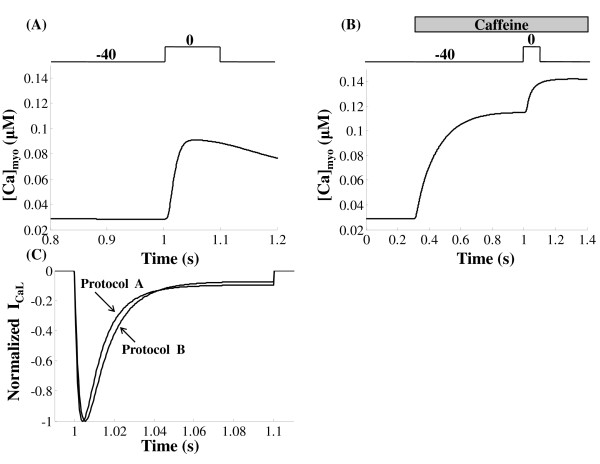
Effects of the application of caffeine. Figure 17: Model-simulated effects of the application of caffeine on ICa,L,TT and [Ca2+]i in a cell dialyzed with 2 mM Fura-2. Changes in [Ca2+]myo resulting from: (A) application of a simple depolarizing pulse from -40 mV to 0 mV, and (B) the same depolarizing pulse following pre-exposure to caffeine (5 mM). Panel (C) compares the ICa,L waveforms associated with these protocols. This model-generated result shows similarity to data in Figure 3, Adachi-Akahane et al. [71].